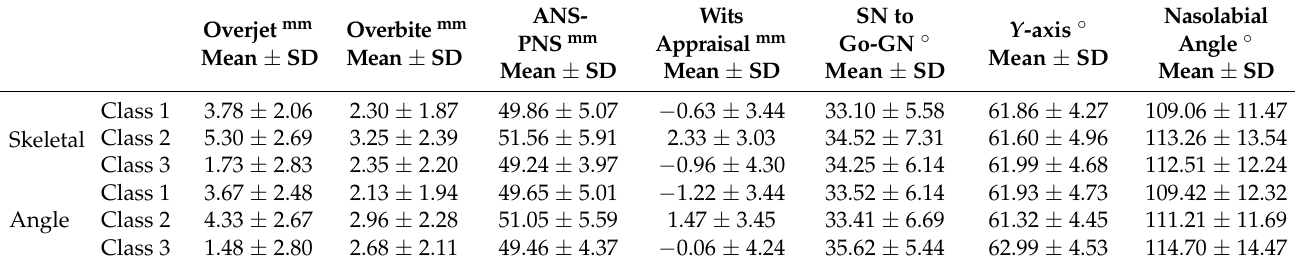
Table 2. Angular and linear cephalometric statistics of